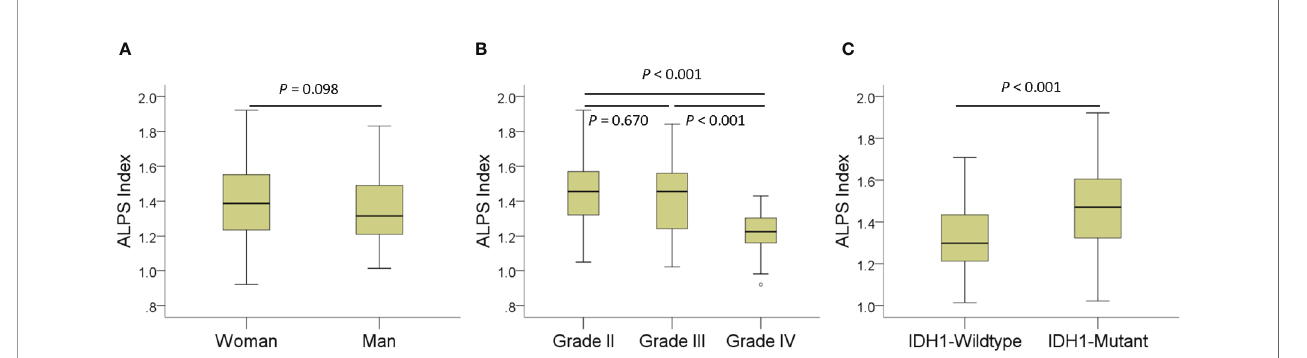
FIGURE 2 | Boxplots showing differences in the analysis along the perivascular space (ALPS) index according to sex (A) , tumor grade (B) , and IDH1 mutation status (C)